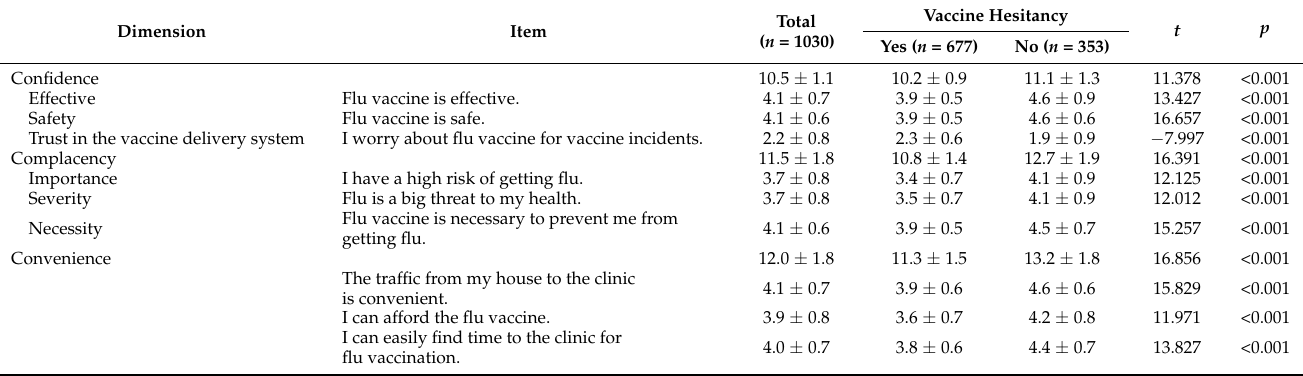
Table 2. Average scores of 1030 respondents in each dimension of the “3Cs”